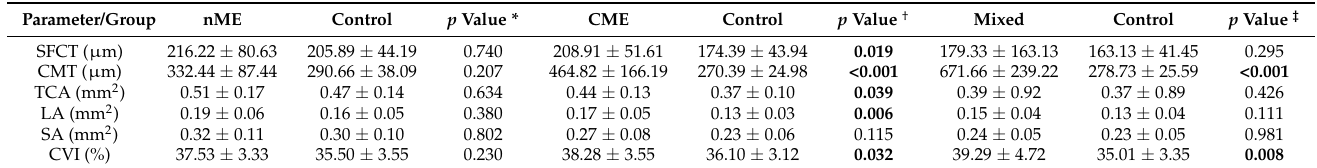
Table 4. Optical coherence tomography parameters according to type of macular oedema secondary to retinal vein occlusion.